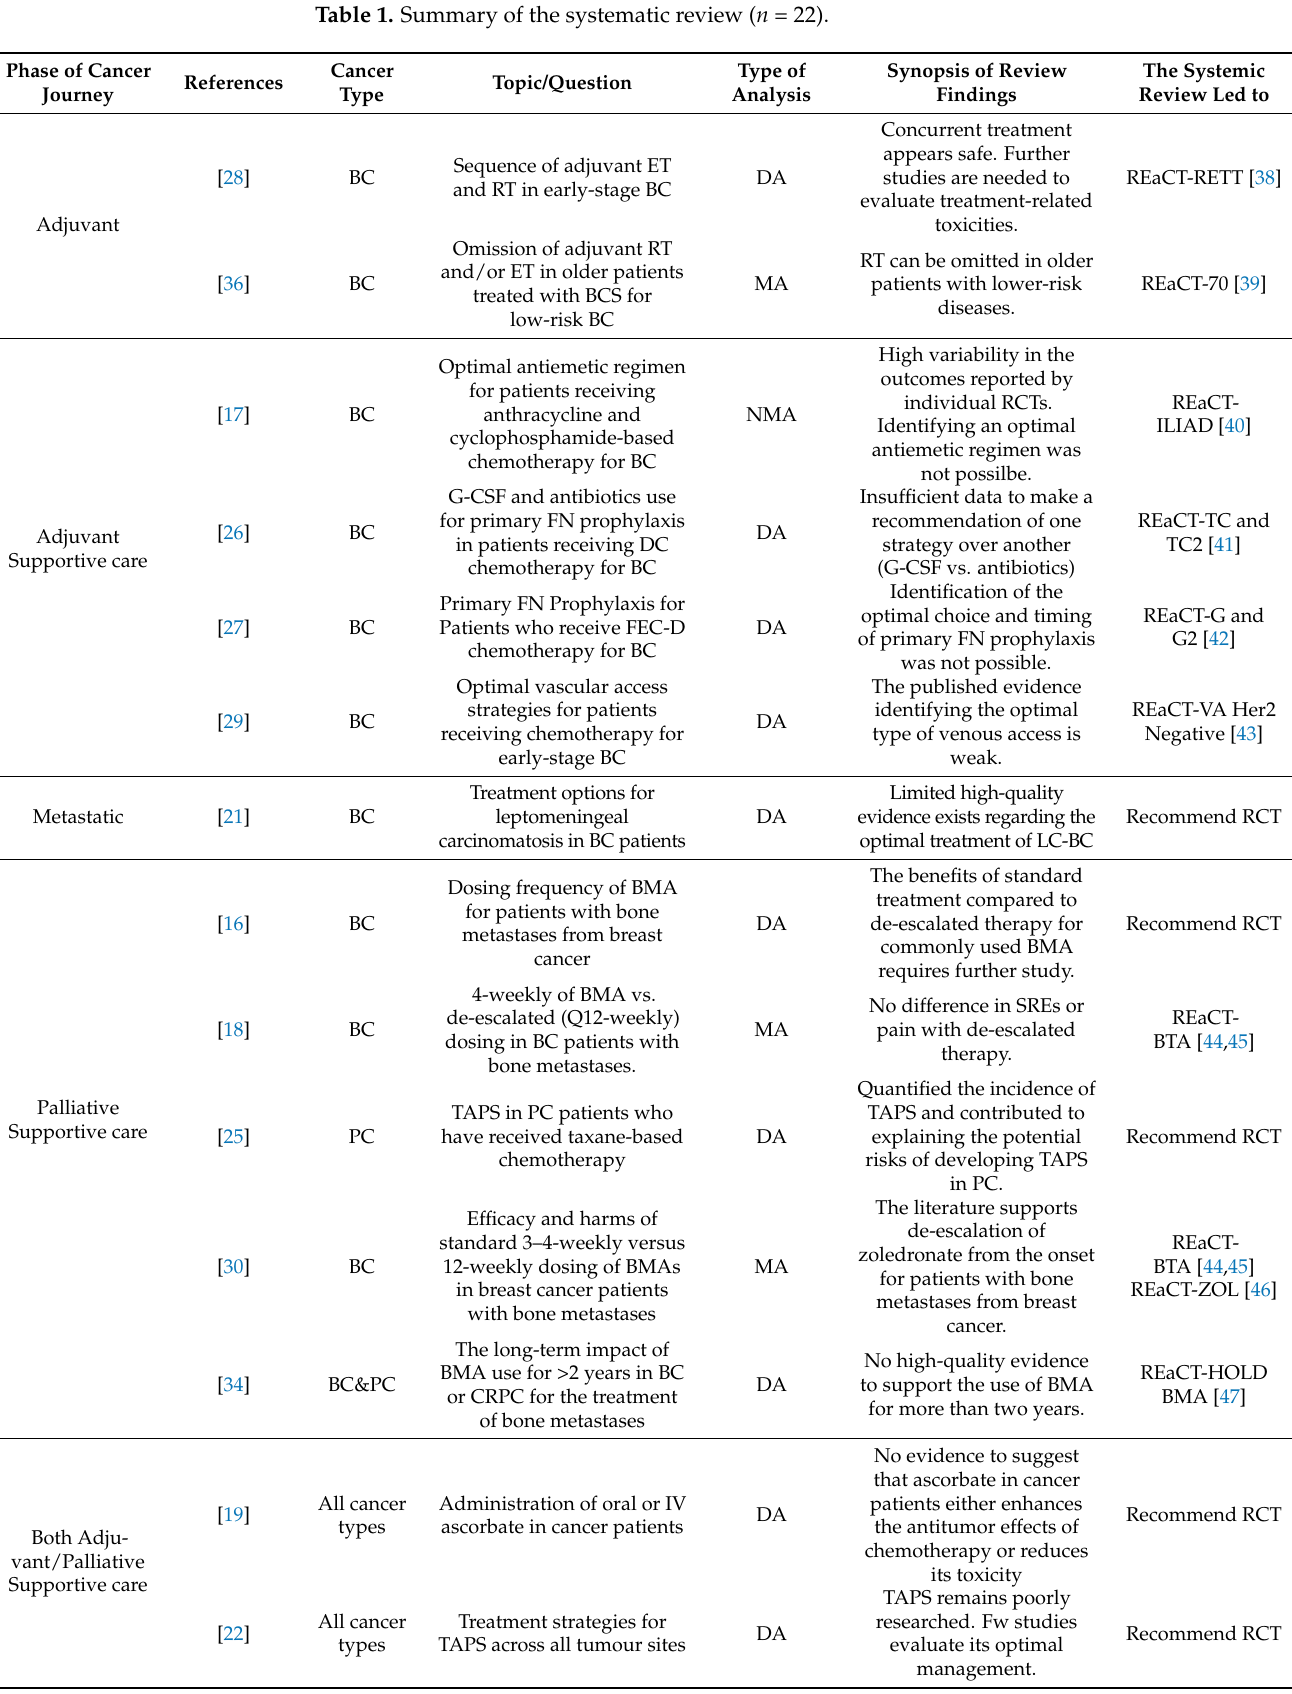
Table 1. Summary of the systematic review ( n =